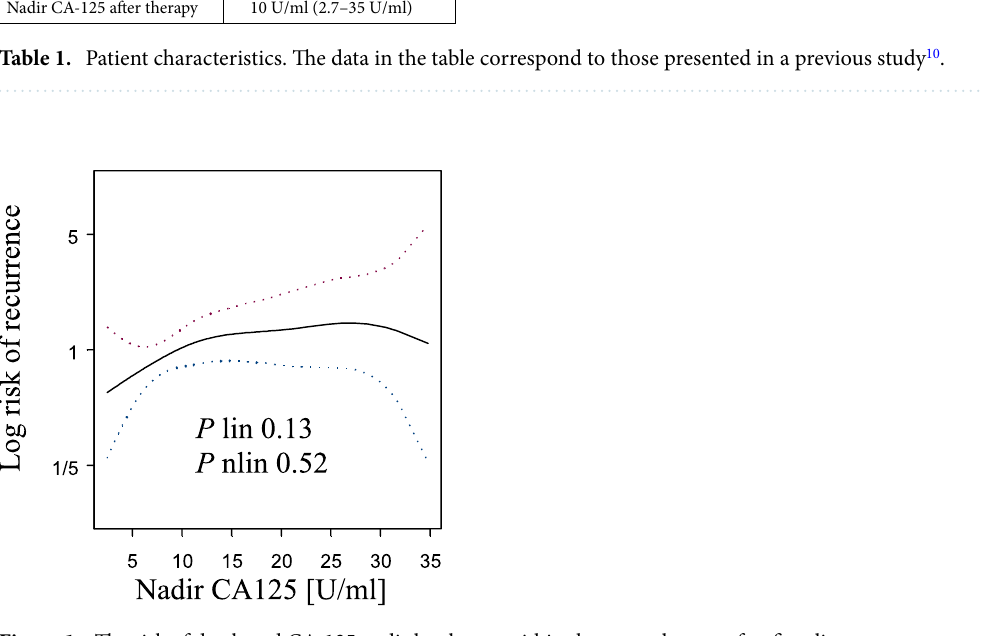
Figure 1. The risk of death and CA-125 nadir level were within the normal range after first-line